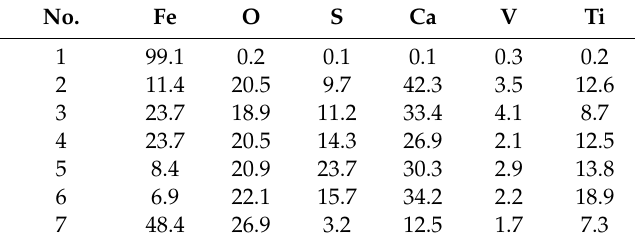
Table 6. EDS of each point in Figure 7 (wt. %).